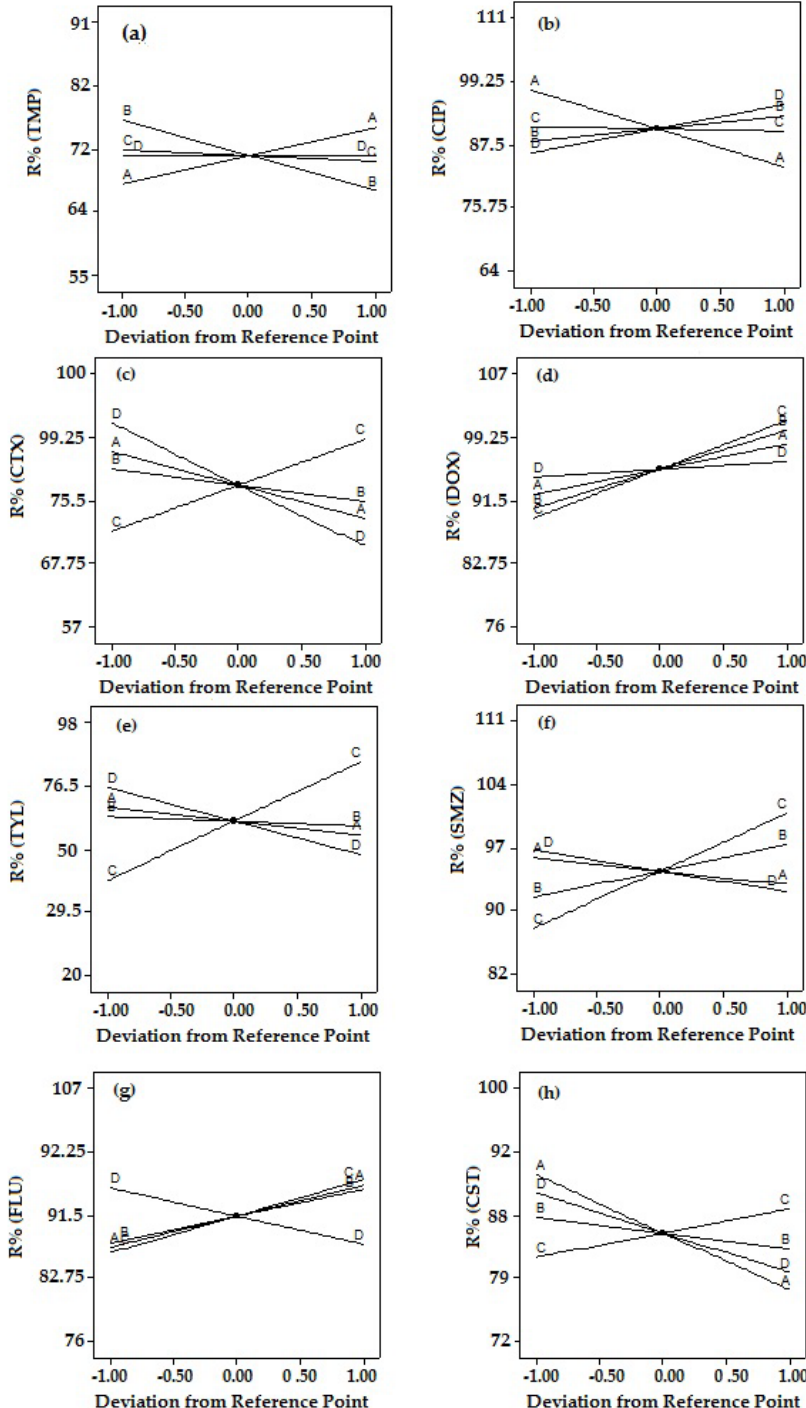
Figure 1. Perturbation plots for screening of factors affecting the extraction procedure, showing the effect of these factors on the recovery percentage of ( a ) TMP, ( b ) CIP, ( c ) CTX, ( d ) DOX, ( e ) TYL, ( f ) SMZ, ( g ) FLU and ( h ) CST, where A is methanol amount, B is acetonitrile amount, C is formic acid (%) and D is the time of extraction.